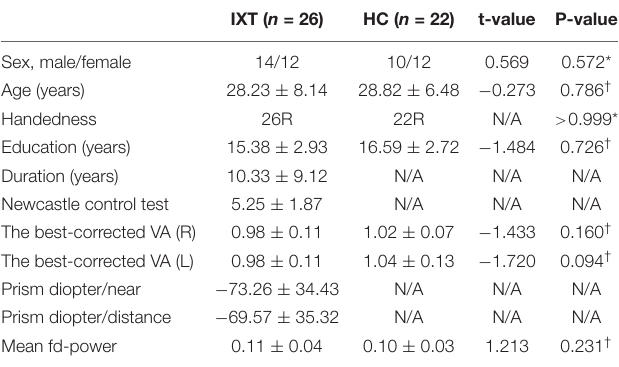
TABLE 1 | Demographics and clinical measurements of IXT patients and